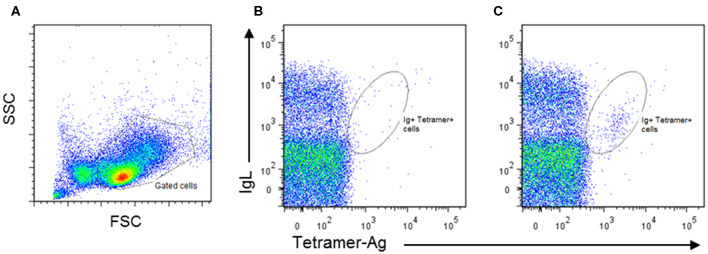
Identification of bovine antigen-specific B cells in peripheral blood mononuclear cells (PBMCs) of an antigen-immunized calf by staining with Phycoerythrin-labeled antigen tetramers: (A) PBMCs isolated from naïve and immunized calves were stained by two-color immunofluorescence with a monoclonal antibody (IL-A58) specific for bovine immunoglobulin light chain (IgL) and antigen tetramer. Representative plots of stained cells from a naïve animal (B) and an immunized animal (C) are presented, showing the presence of an IgL+ Tetramer-Ag+ population in the immunized animal. Approximately 1% of IgL+Tetramer-Ag+ B cells were detected in the immunized calve, compared to <0.2% in the unimmunized control.